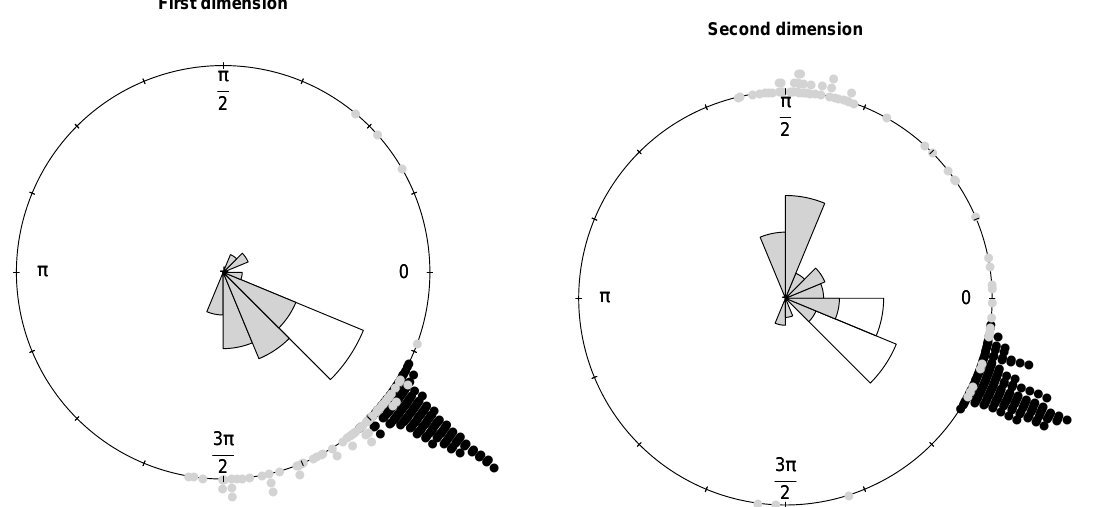
Figure 7. Protein data. MLE (dashed), WLE (solid), MCD (dotted), and MM (dash-dotted). ( Left ): Data and fitted model on a flat torus. ( Right ): Unwrapped data and fitted model for j = ( 0,0 ) . First dimension